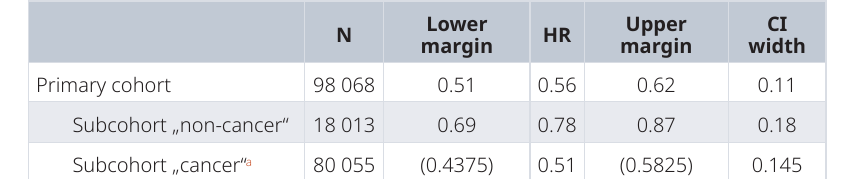
Table 2. VA study of Krebs et al. 2011: HR and 95%